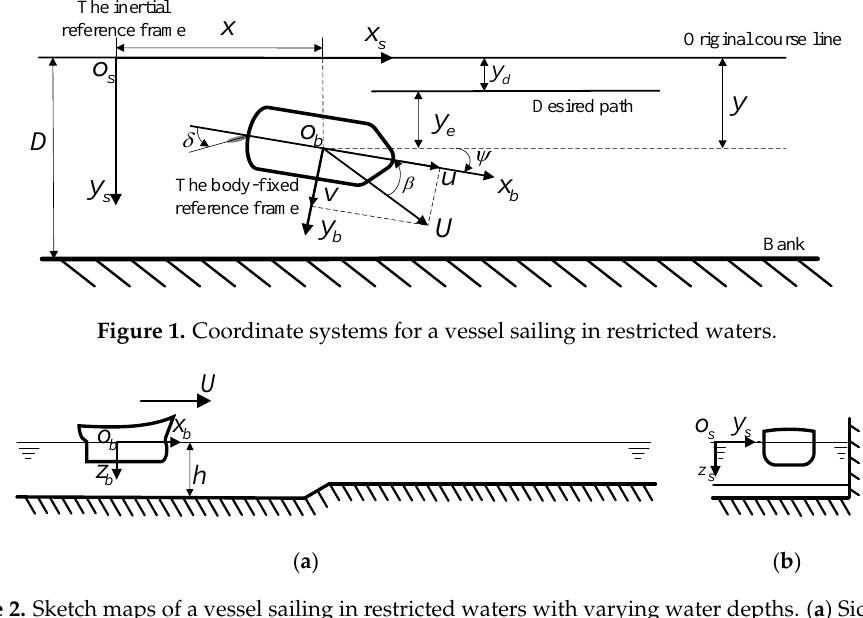
Figure 2. Sketch maps of a vessel sailing in restricted waters with varying water depths. ( a ) Side view; ( b ) rear view.